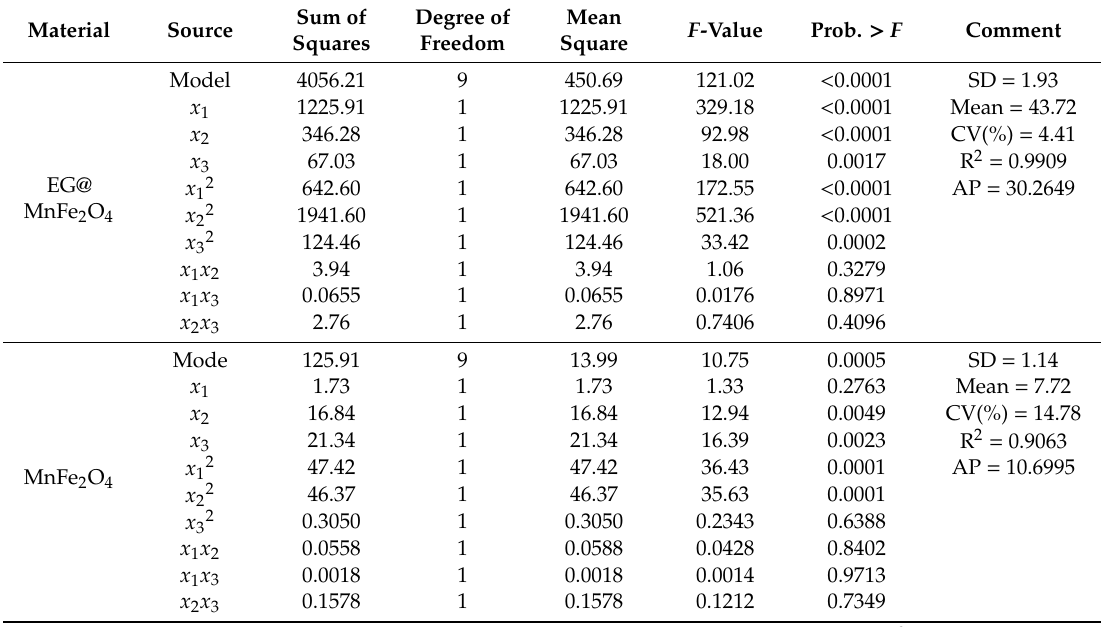
Table 5. ANOVA data for the model of CR